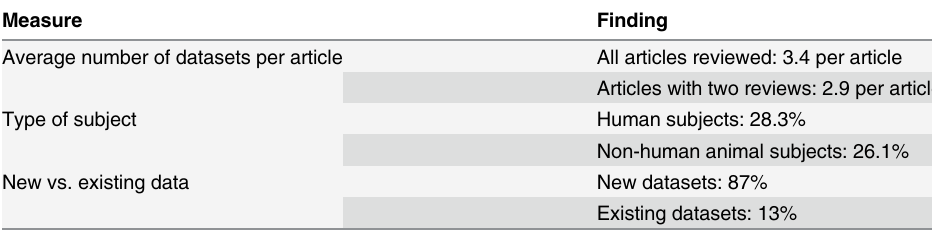
Table 8. Summary of Analysis of Invisible